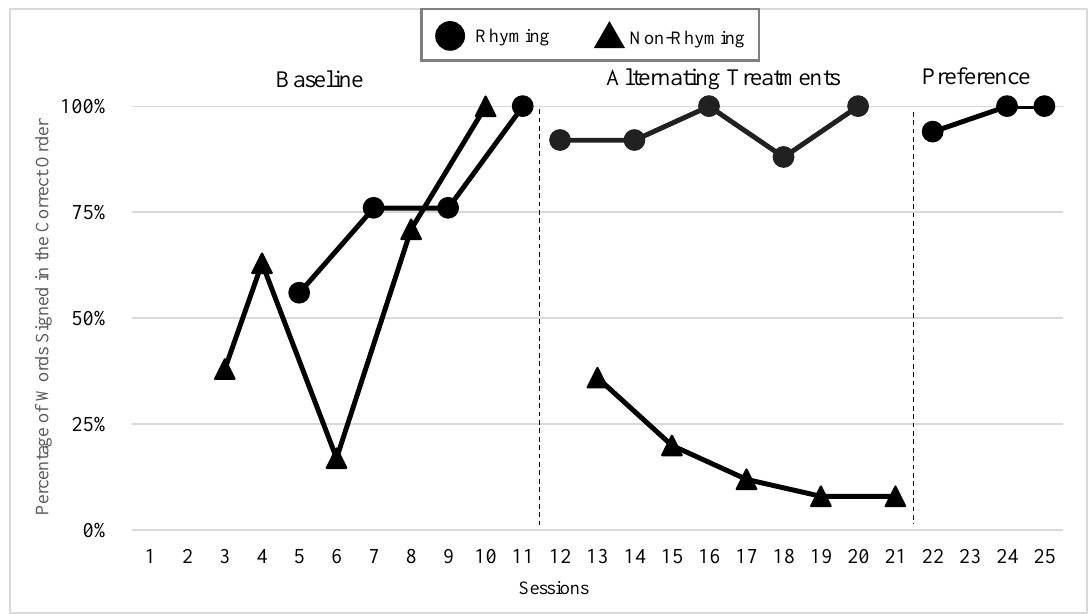
Figure 12. Giada’s Percentage of Words Signed in the Correct Order in Recitation. Children 2020 , 7 , x FOR PEER REVIEW